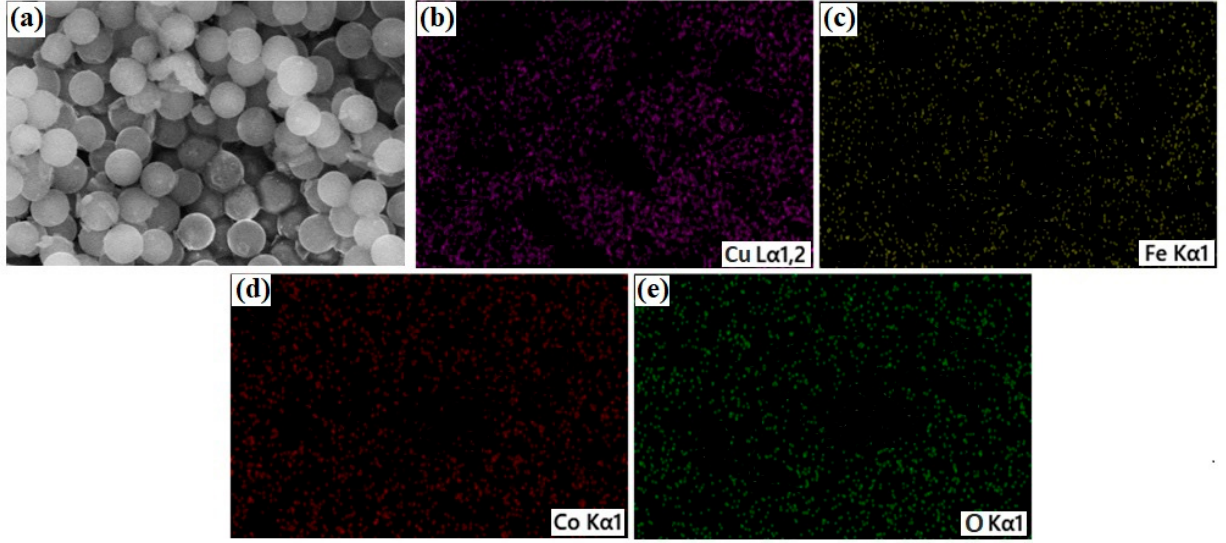
Figure 3. Elemental mapping of Co 0.4 Cu 0.6 Fe 2 O 4 nanoparticles ( a ) FE-SEM, ( b ) Cu, ( c ) Fe, ( d ) Co and ( e ) O.